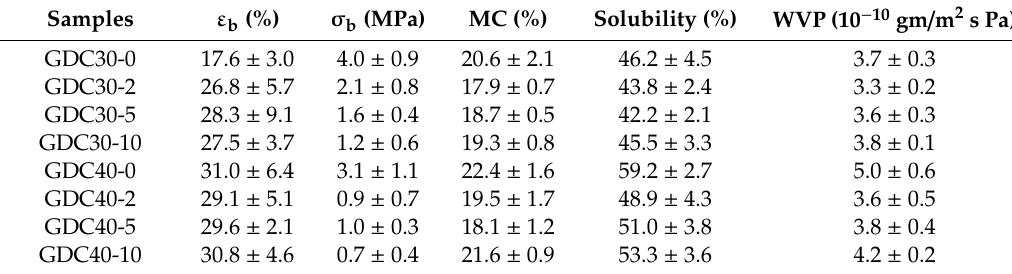
Table 2. Tensile properties, MC, solubility, and WVP of the FK / DCMC films plasticized with 30% and 40% glycerol content,